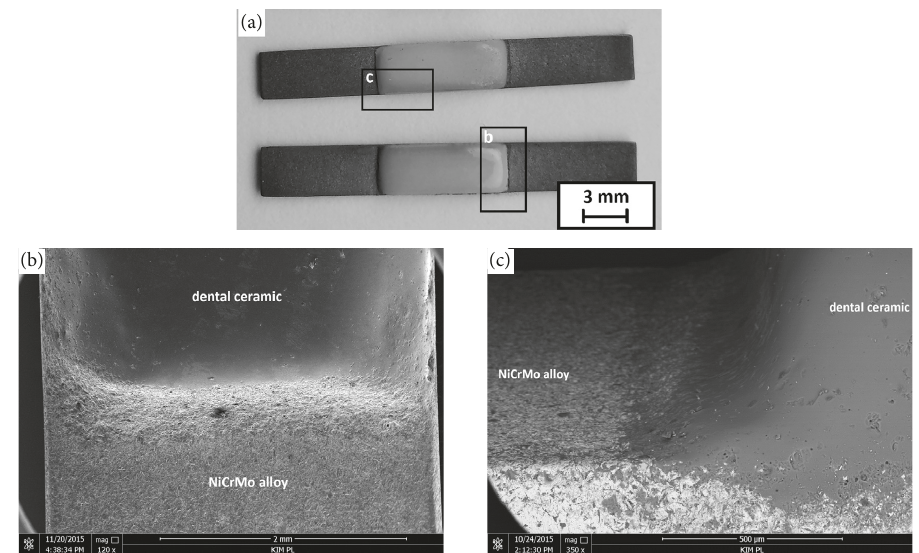
Figure 1: The exemplary groups (SEM images): (a) specimens used for the bending test; (b) metal-ceramic bond surface (view from the top); (c) metal-ceramic bond surface (lateral view) .